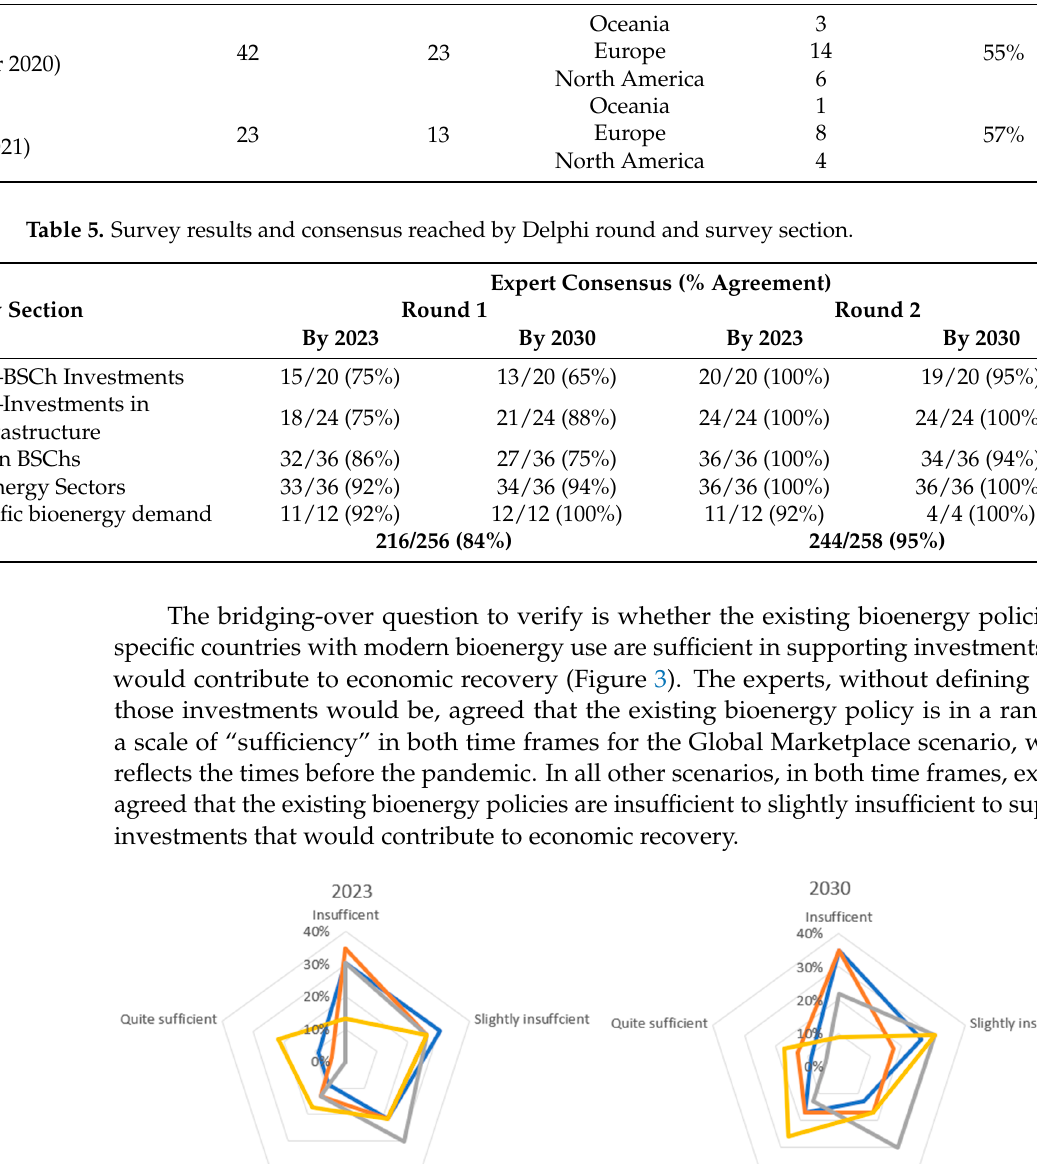
Table 5. Survey results and consensus reached by Delphi round and survey section.